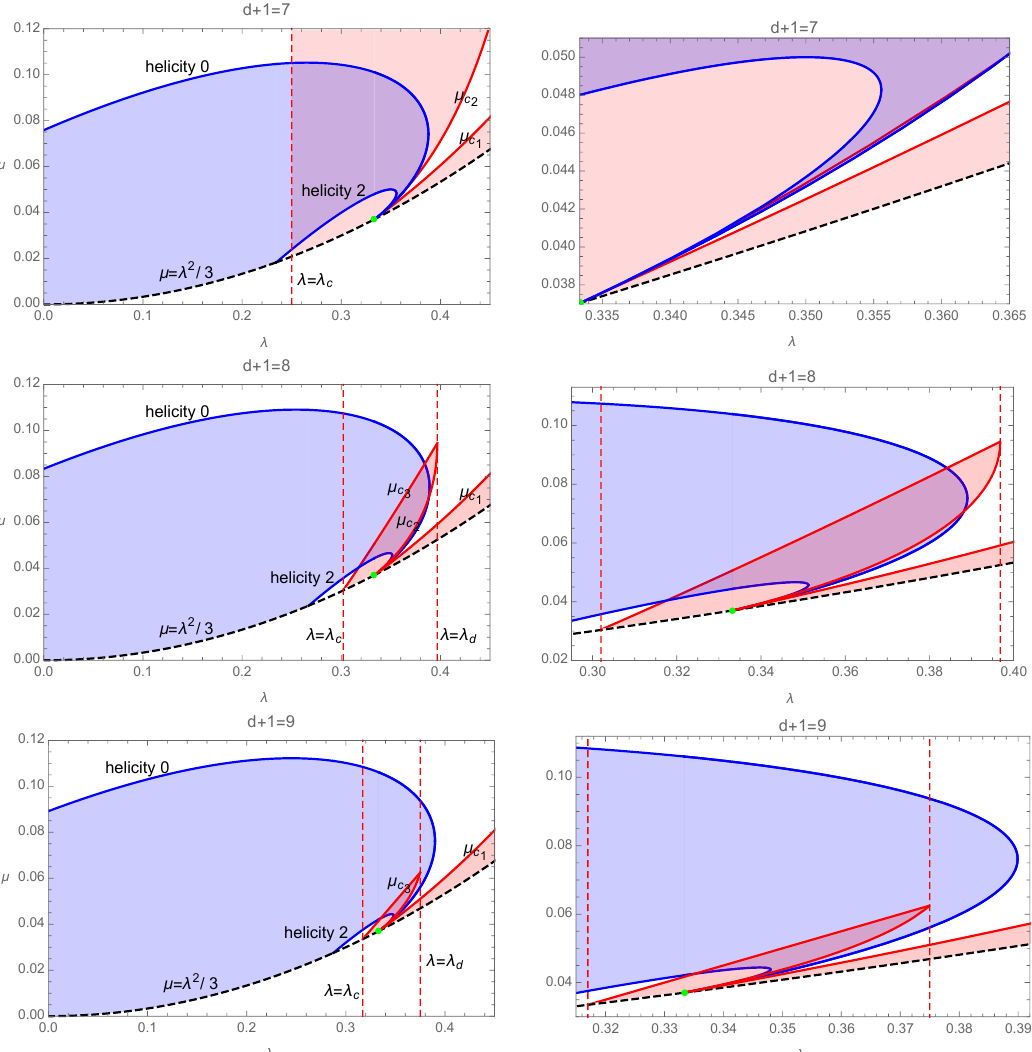
Figure 3. Parameter space of third order Lovelock in 7, 8 and 9-dimensions. The shadowed blue region is the allowed region due to boundary causality. The shadowed red region indicates the region where phase transitions between small and large black holes occur. The green dot represents the maximally symmetric AdS spacetime with ( (cid:21); (cid:22) ) = (1 = 3 ; 1 = 27) for which no phase transition occurs. It is visible that as the spacetime dimensions increase the regions that phase transitions occur shrink. Also both (cid:21) c ; (cid:21) d ! 1 = 3 when d ! 1 .